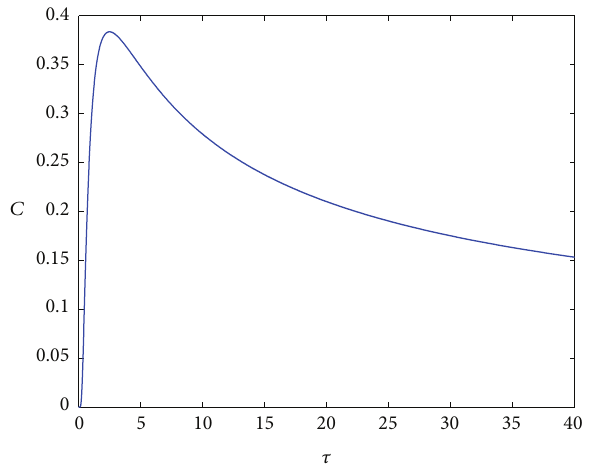
Figure 3: Contaminant concentration profile as time evolves.